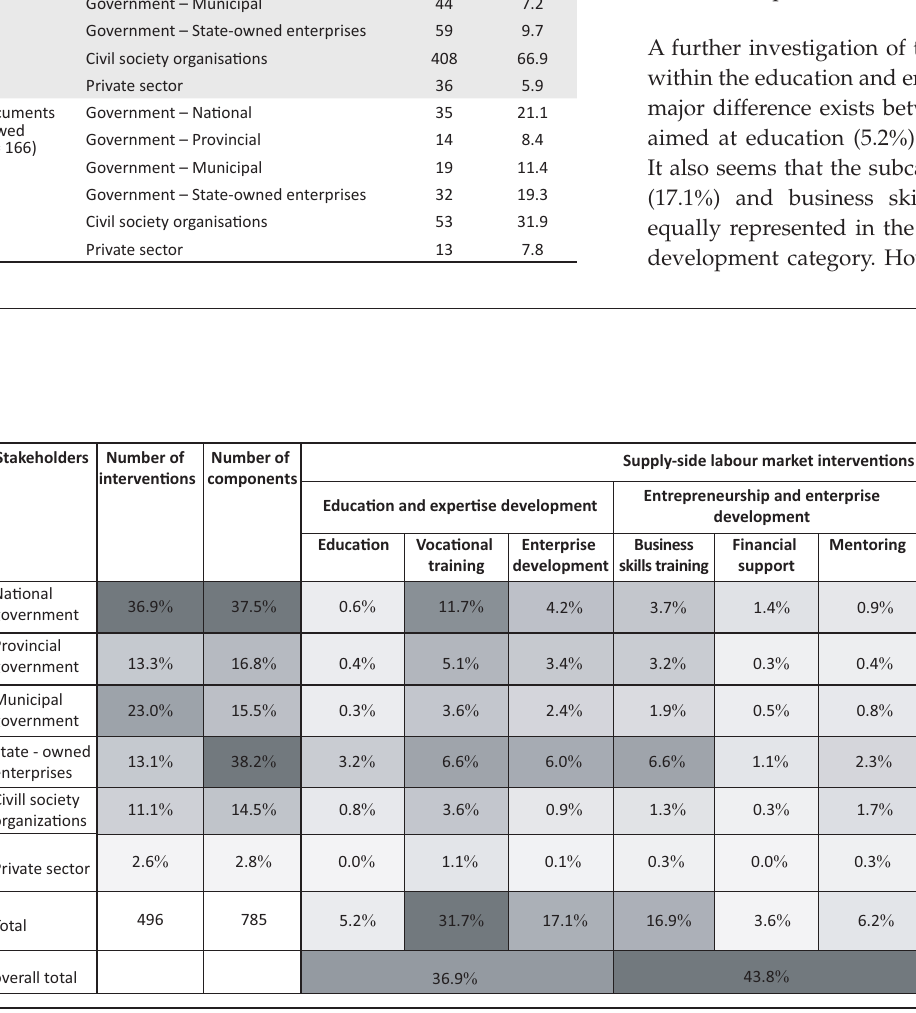
FIGURE 1: Findings of the study ( n =496).